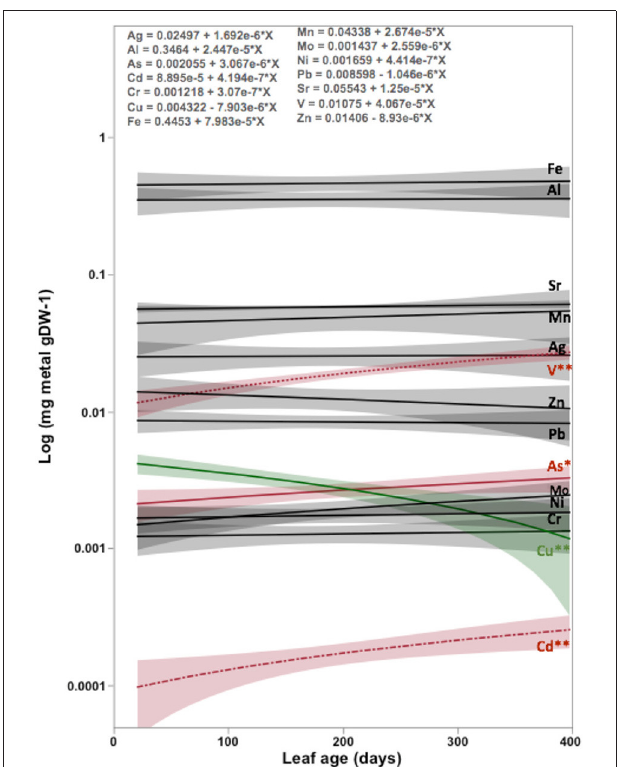
FIGURE 3 | The increase of metal content with the age of Avicennia marina leaves in the Central Red Sea. The slopes of the fitted linear regressions provide an estimate of metal accumulation rate (units mg metal leaf − 1 ). Results from ANOVA testing differences during leaf age. * = 0.05 > P >